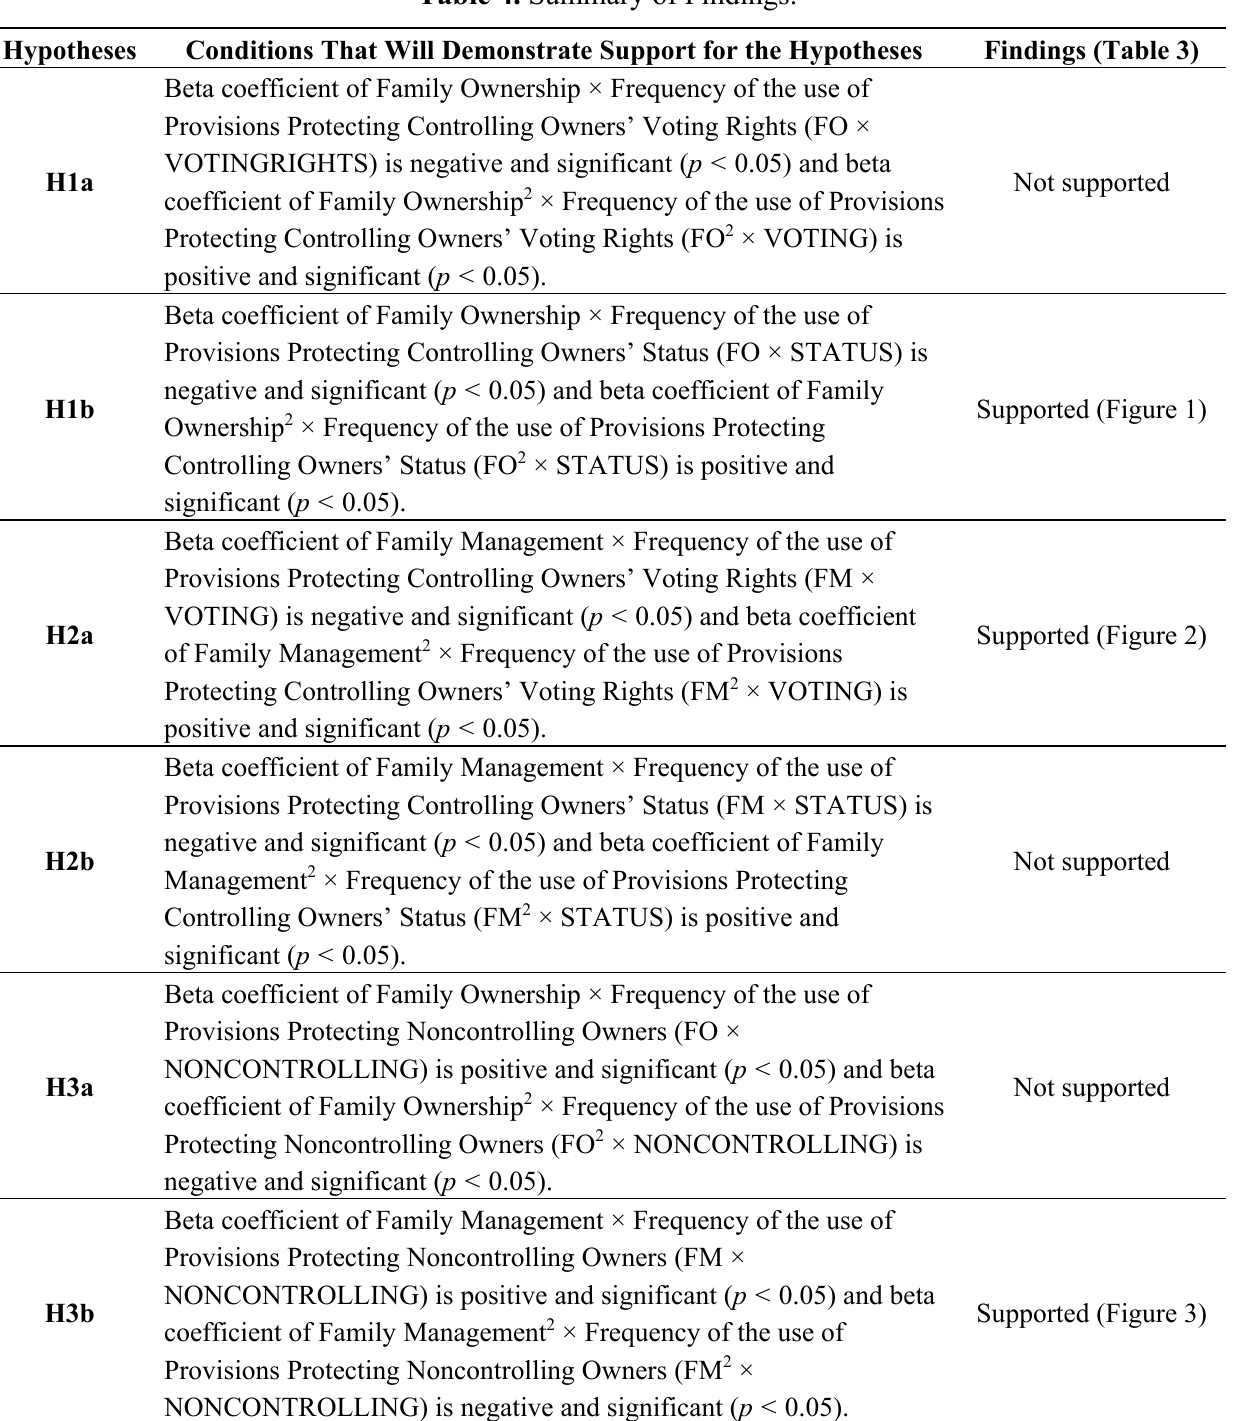
Table 4. Summary of